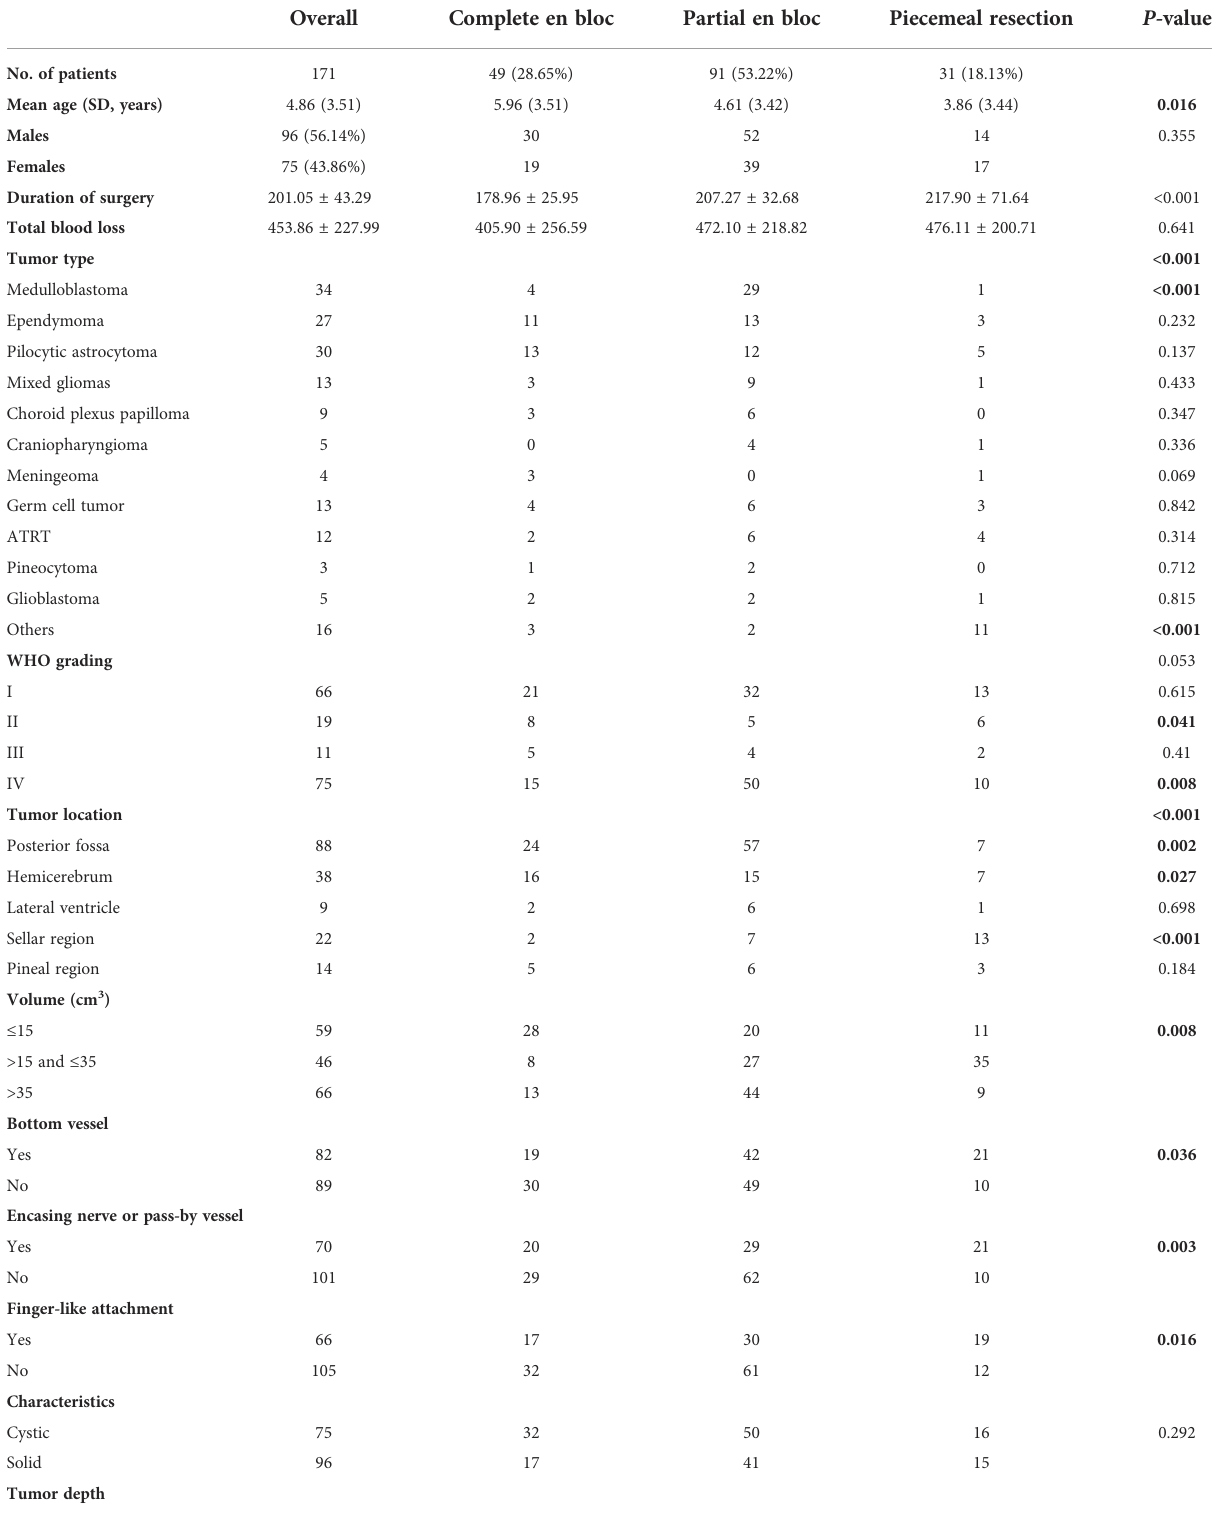
TABLE 2 Demographic and tumor